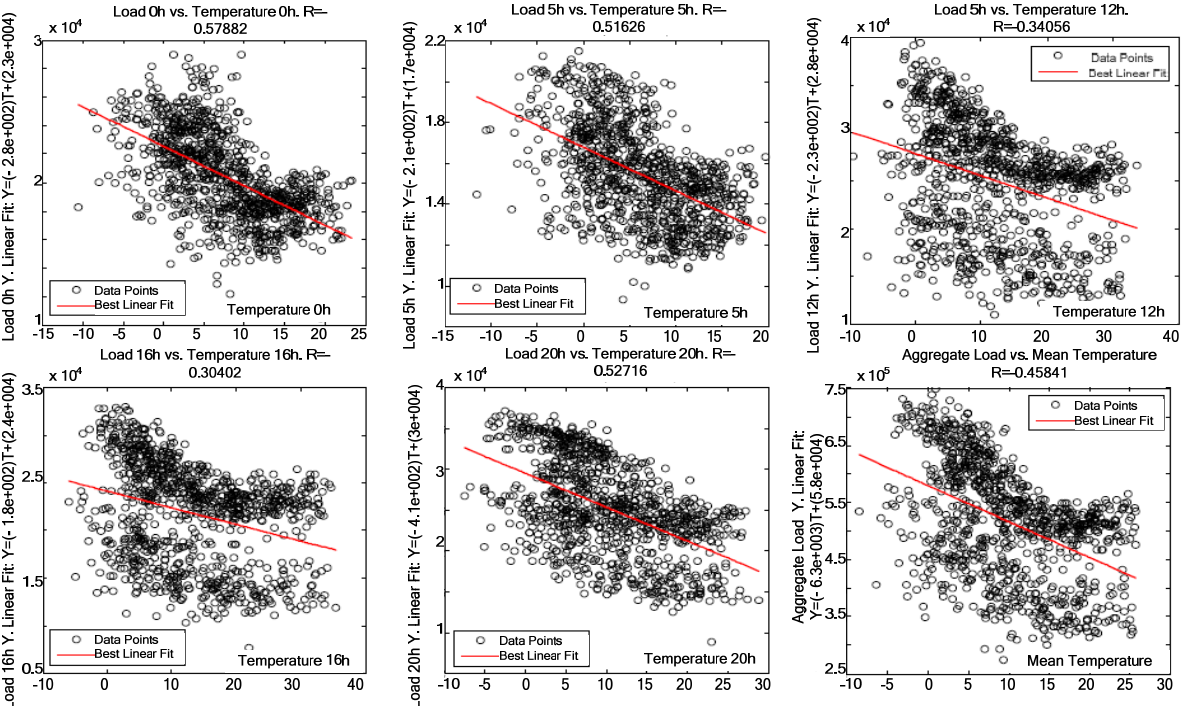
Figure 10. Correlation at 0 h, 5 h, 12 h, 16 h, 20 h and average temperature against electric power